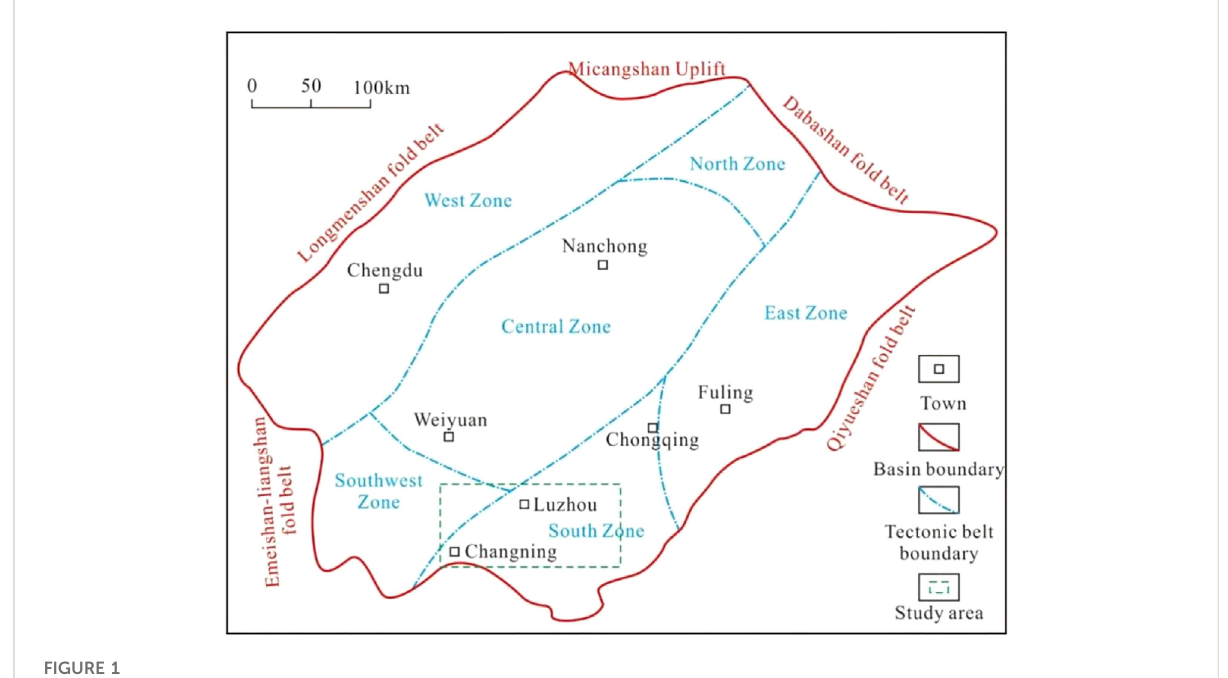
FIGURE 1 Location of the study area (Tang et al.,